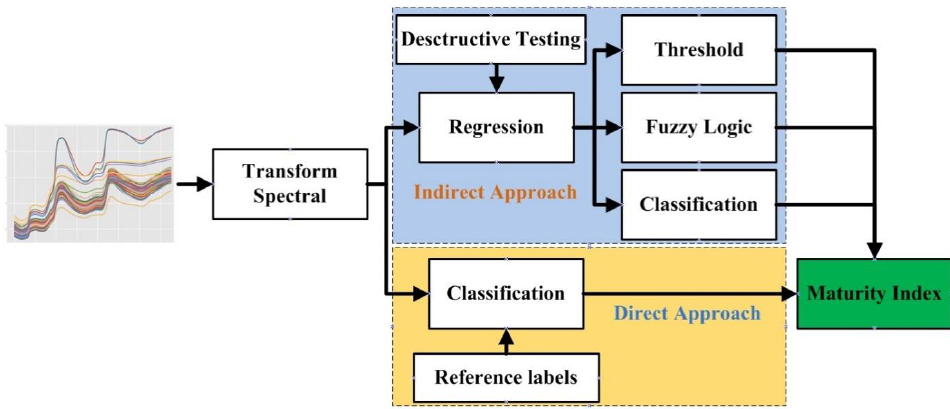
Figure 4. Approach for determining the maturity